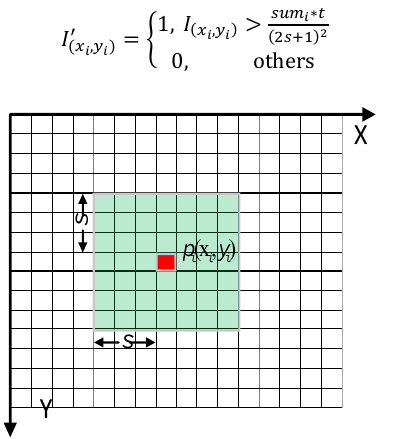
Figure 12. Adaptive threshold segmentation